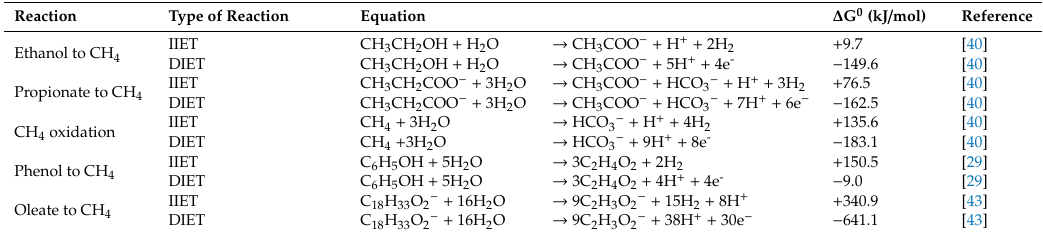
Table 1. Gibbs free energies for various reactions, under indirect interspecies electron transfer (IIET) and direct interspecies electron transfer (DIET)